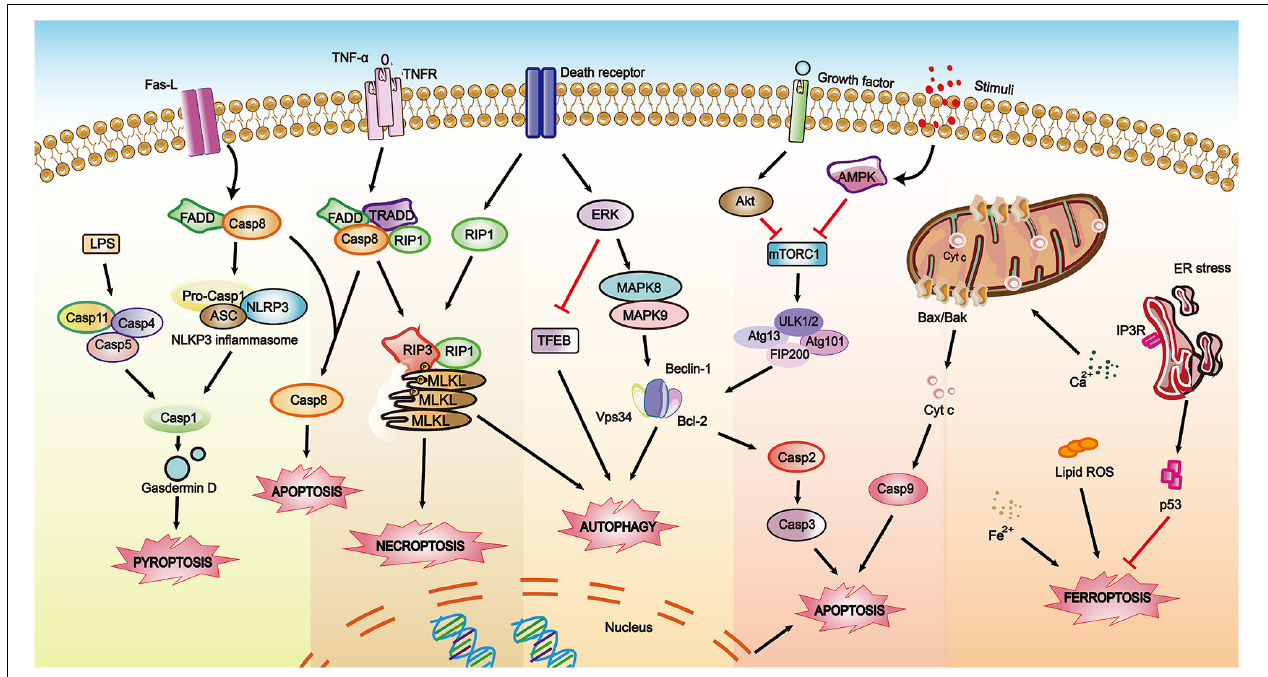
FIGURE 3 | A schematic diagram showing biomarkers involved in RCDs within depicting the cross-regulations among different pathways. The solid arrows indicate activating interactions while the T-shaped lines indicate inhibitory